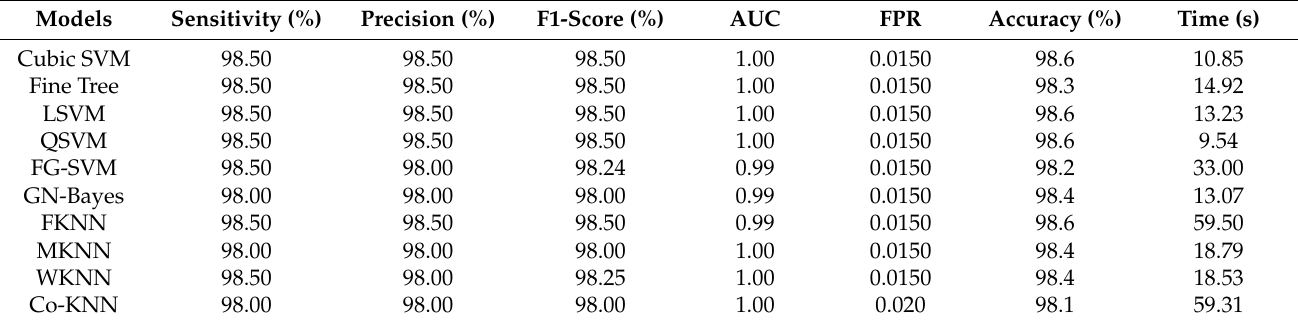
Table 15. Classification results using Fine-tuned Nasnet deep features for INbreast. Models